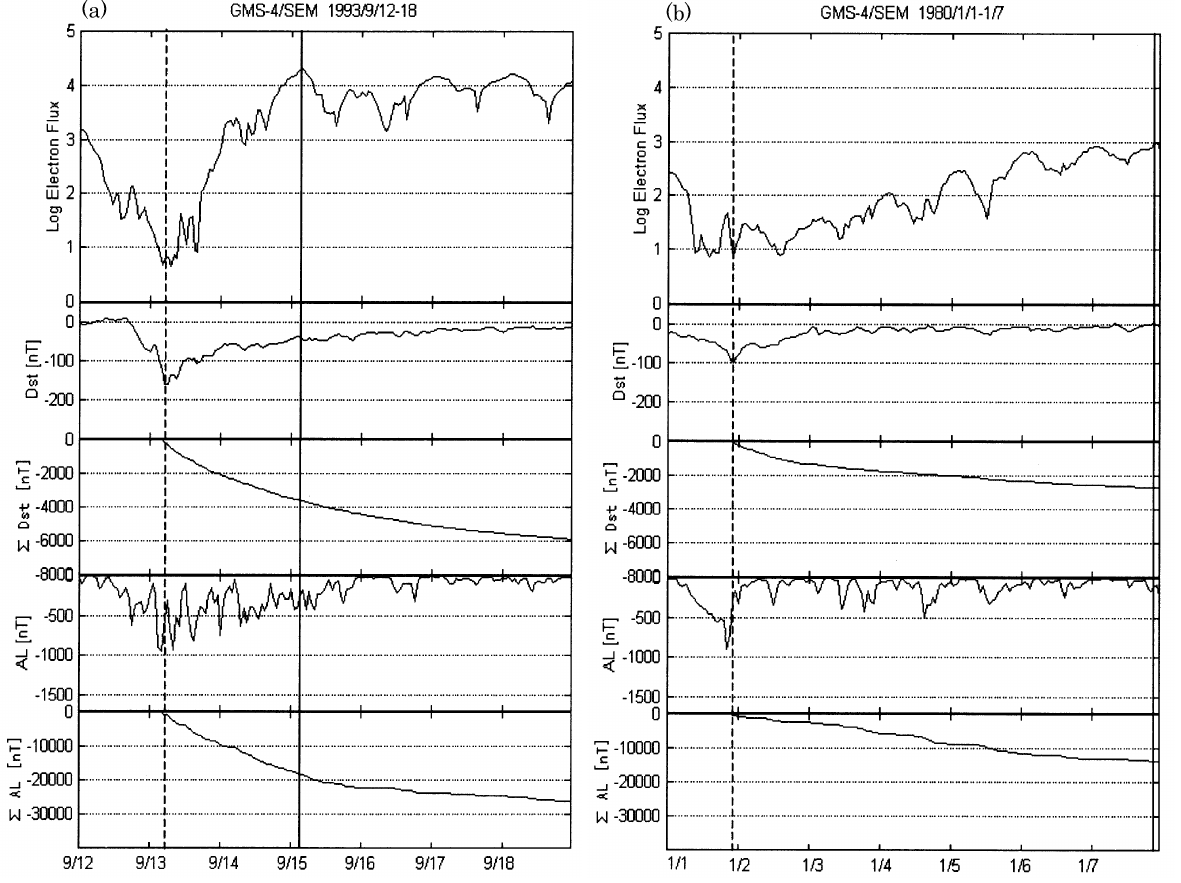
Fig. 1. Examples of enhancements of relativistic ( > 2MeV) electron flux observed by Geostationary Meteorological Satellite and D st / AL indices (a) for the the storm of 12–18 September 1993, and (b) for the storm of 1–7 January 1980. 6D st and 6AL are also plotted, where 6 denotes the summation from the time of the minimum D st . The minimum D st is represented with a dashed vertical line, and a solid line represents the time for the peak electron flux for the six-day period after the D st